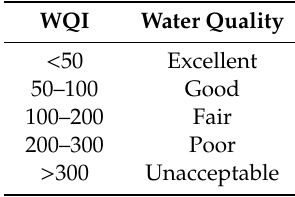
Table 5. Classification of the Water Quality Index.